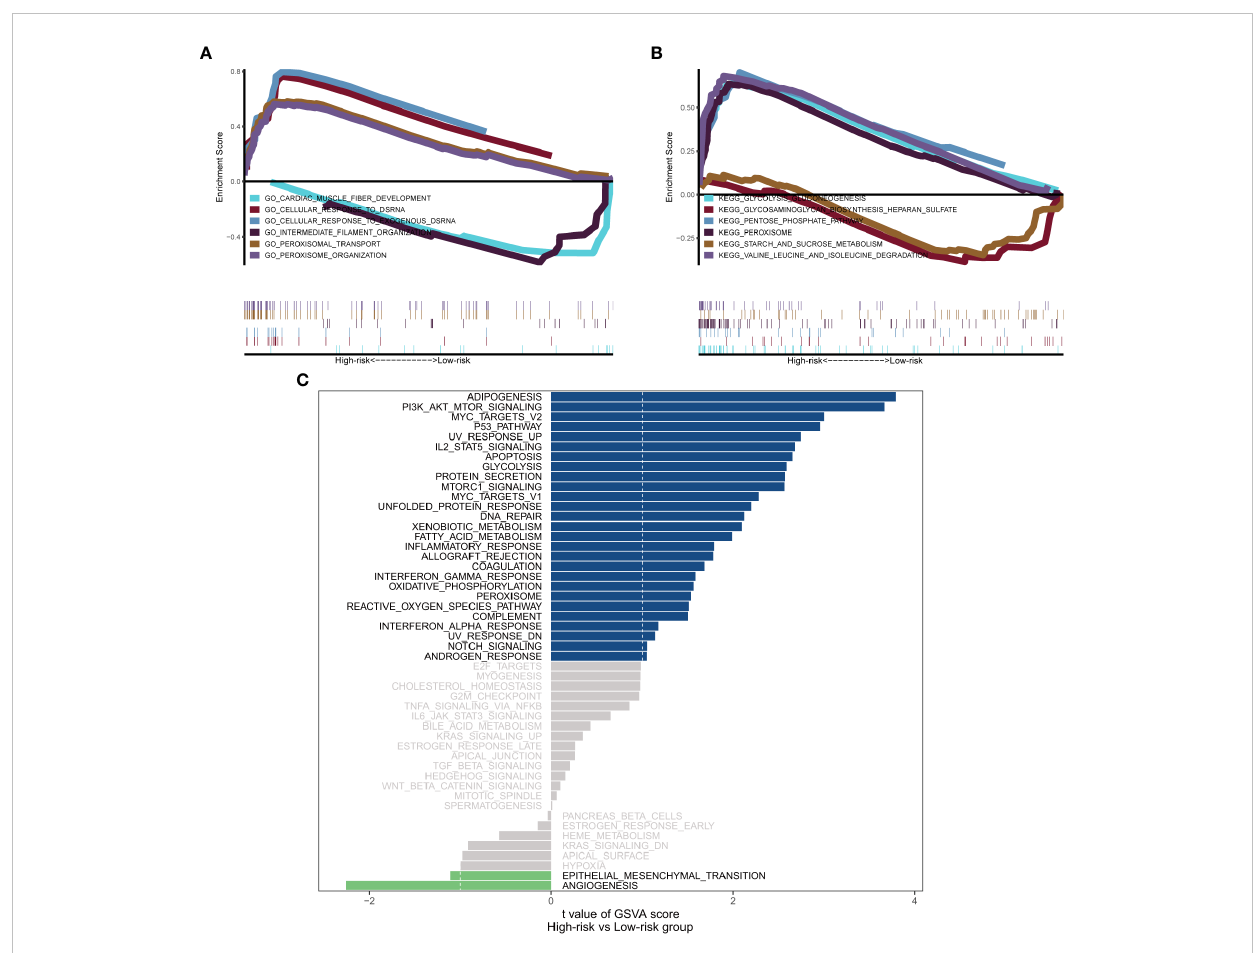
FIGURE 7 Biological phenotypes associated with Gene6 risk score. (A, B) GSEA results of Gene6 risk score in GO and KEGG. (C) GSVA result of Gene6 risk